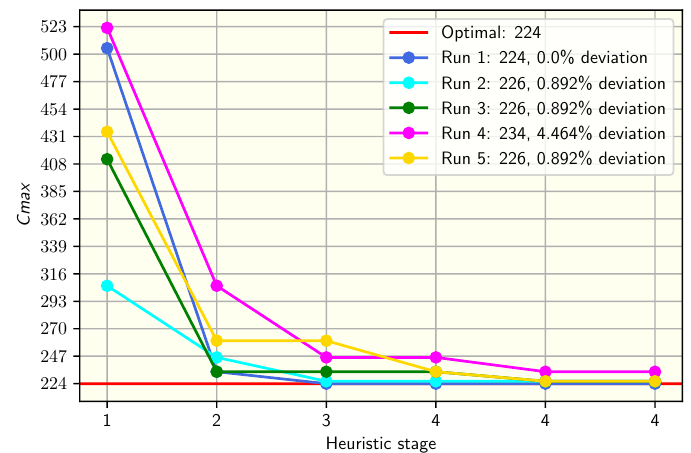
Figure 2. Five runs and its results for a small instance in alternative